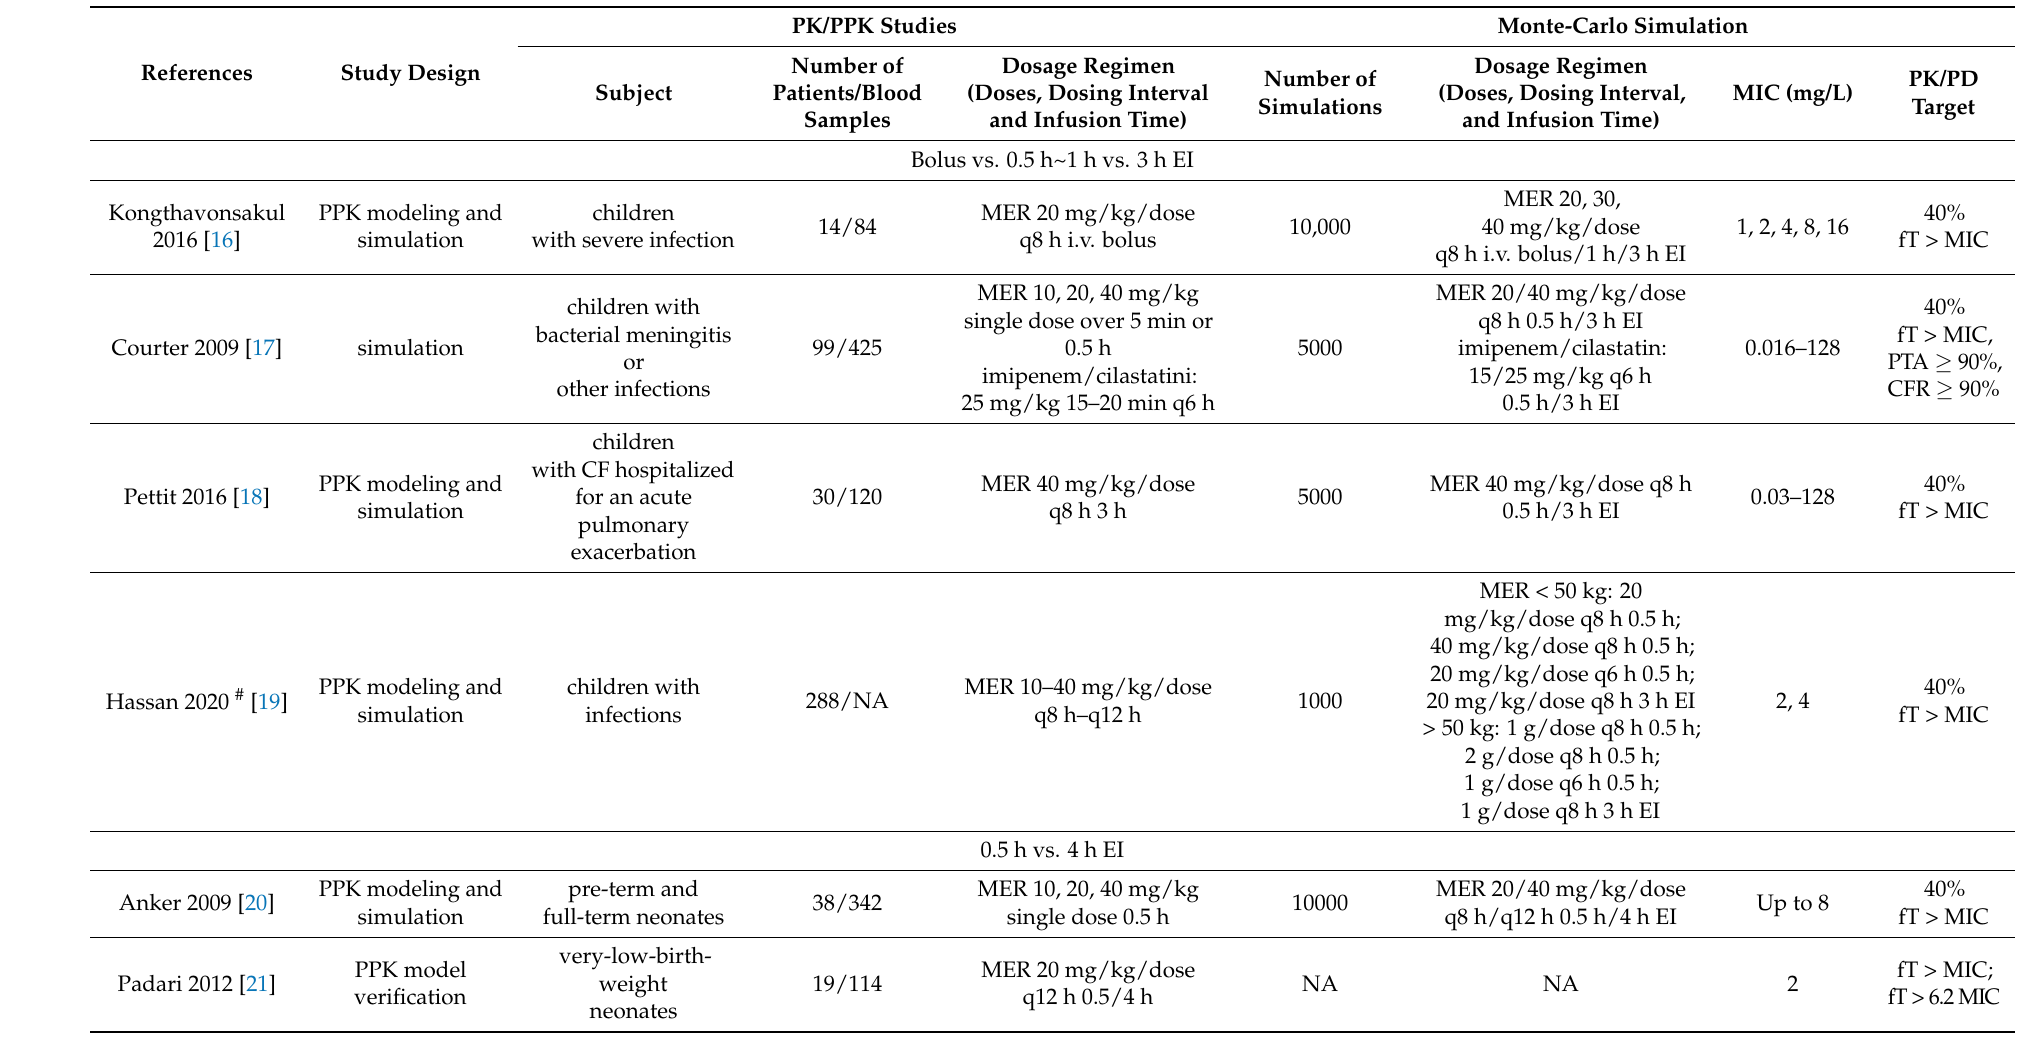
Table 2. Basic information of included PK/PPK